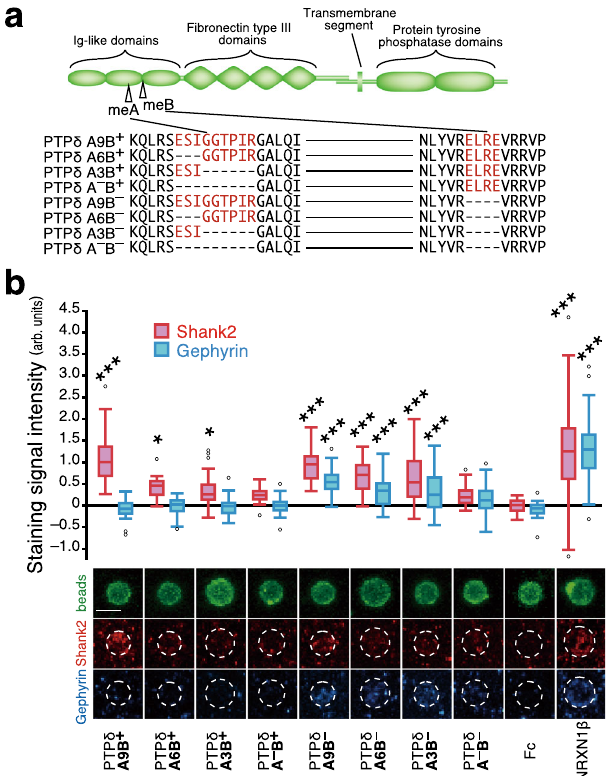
Fig. 1 Properties of PTP δ splice variants to induce postsynaptic differentiation. a Schematic structure of PTP δ and amino acid sequences of splice variants in Ig-like domains. me A and B sequences are colored in red. b Induction of postsynaptic differentiation of cerebral cortical neurons by beads conjugated with ECDs of PTP δ splice variants. Excitatory and inhibitory postsynaptic terminals were visualized by immunostaining for Shank2 (red) and gephyrin (blue), respectively (bottom). Shank2 (red bars) and gephyrin (blue bars) staining signals on the beads ( n = 35, 35, 37, 38, 35, 35, 36, 35, 35, and 35 for PTP δ A9B + , A6B + , A3B + , A – B + , A9B – , A6B – , A3B – , A – B – , Fc, and NRXN1 β beads, respectively) were quanti fi ed (top). Scale bar, 5 μ m. Data are presented as box plots. Horizontal line in each box shows the median, the box shows the interquartile range (IQR) and the whiskers are 1.5 × IQR. * P < 0.05 and *** P < 0.001, Tukey ’ s post hoc test compared to control Fc beads. See Supplementary Table 4 for additional statistics and exact p